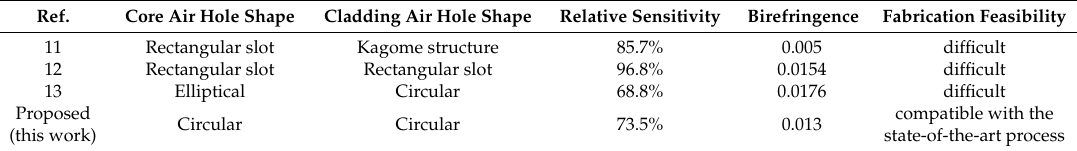
Table 1. Comparison of the proposed designed fiber with other reported fibers in the literature for sensing